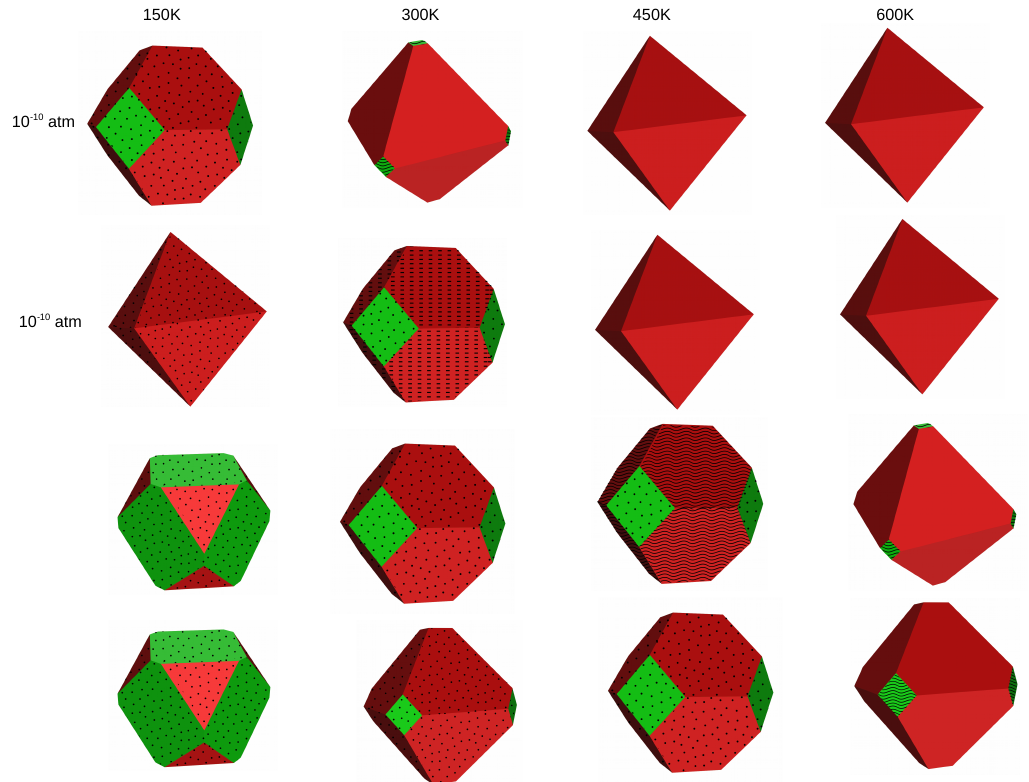
Figure 4. The effect of temperature on the morphology and composition of the SrF 2 crystal at four pressure conditions—surface (111) in red and (100) in green. The clean surfaces are indicated by empty planes, the dotted planes correspond to 100% HF coverage, wavy lines to 50% HF coverage and dashed planes to 25% HF